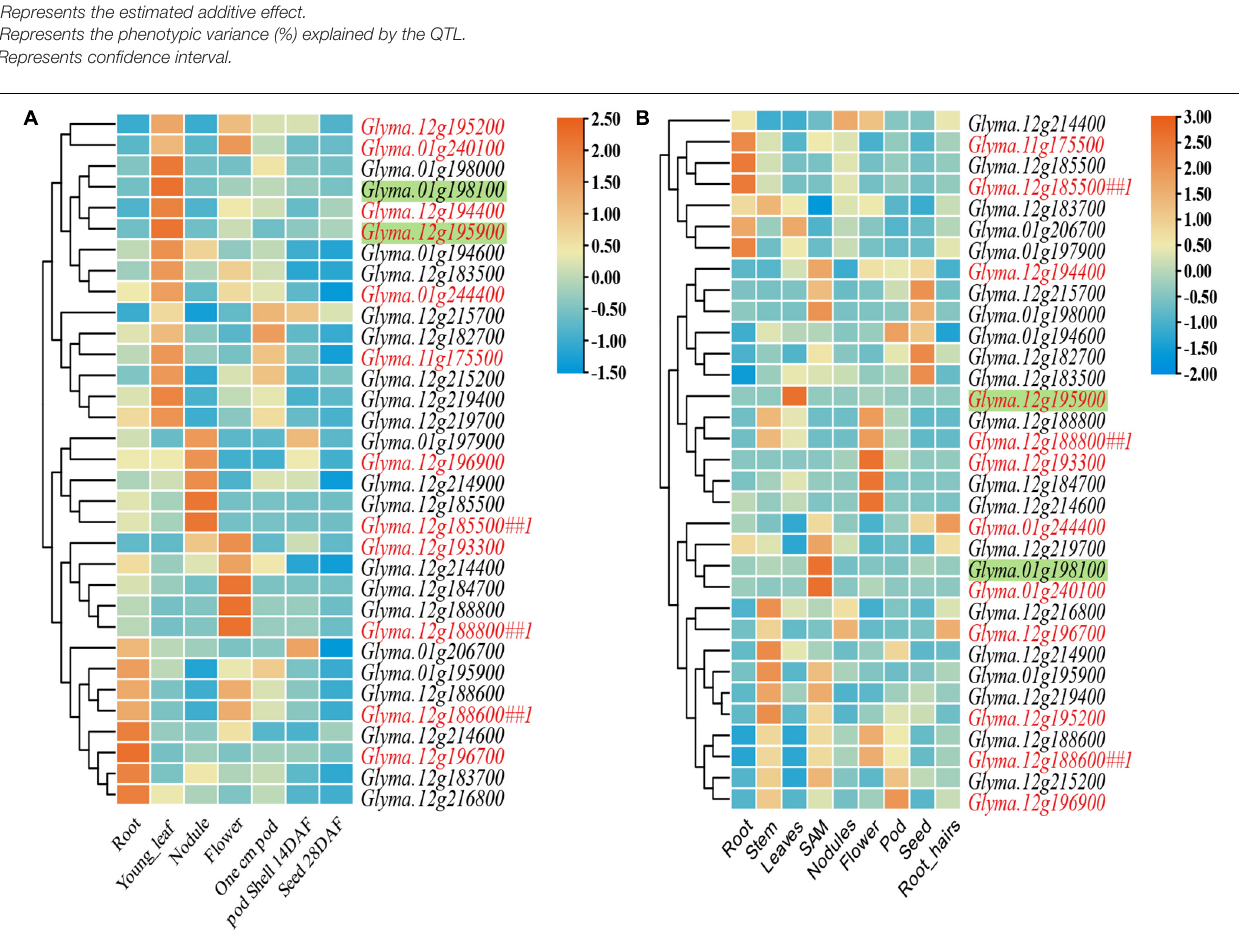
FIGURE 3 | Heatmap of expression data from SoyBase (A) and Phytozome (B) for 21 and 12 candidate genes of pubescence length (PL) and pubescence density (PD). The candidate gene names of PL and PD are in black and red, respectively. The gene name with ##1 represents the candidate gene for both PL and PD. The gene name with shadow represents the important candidate genes identified by differential expression in two